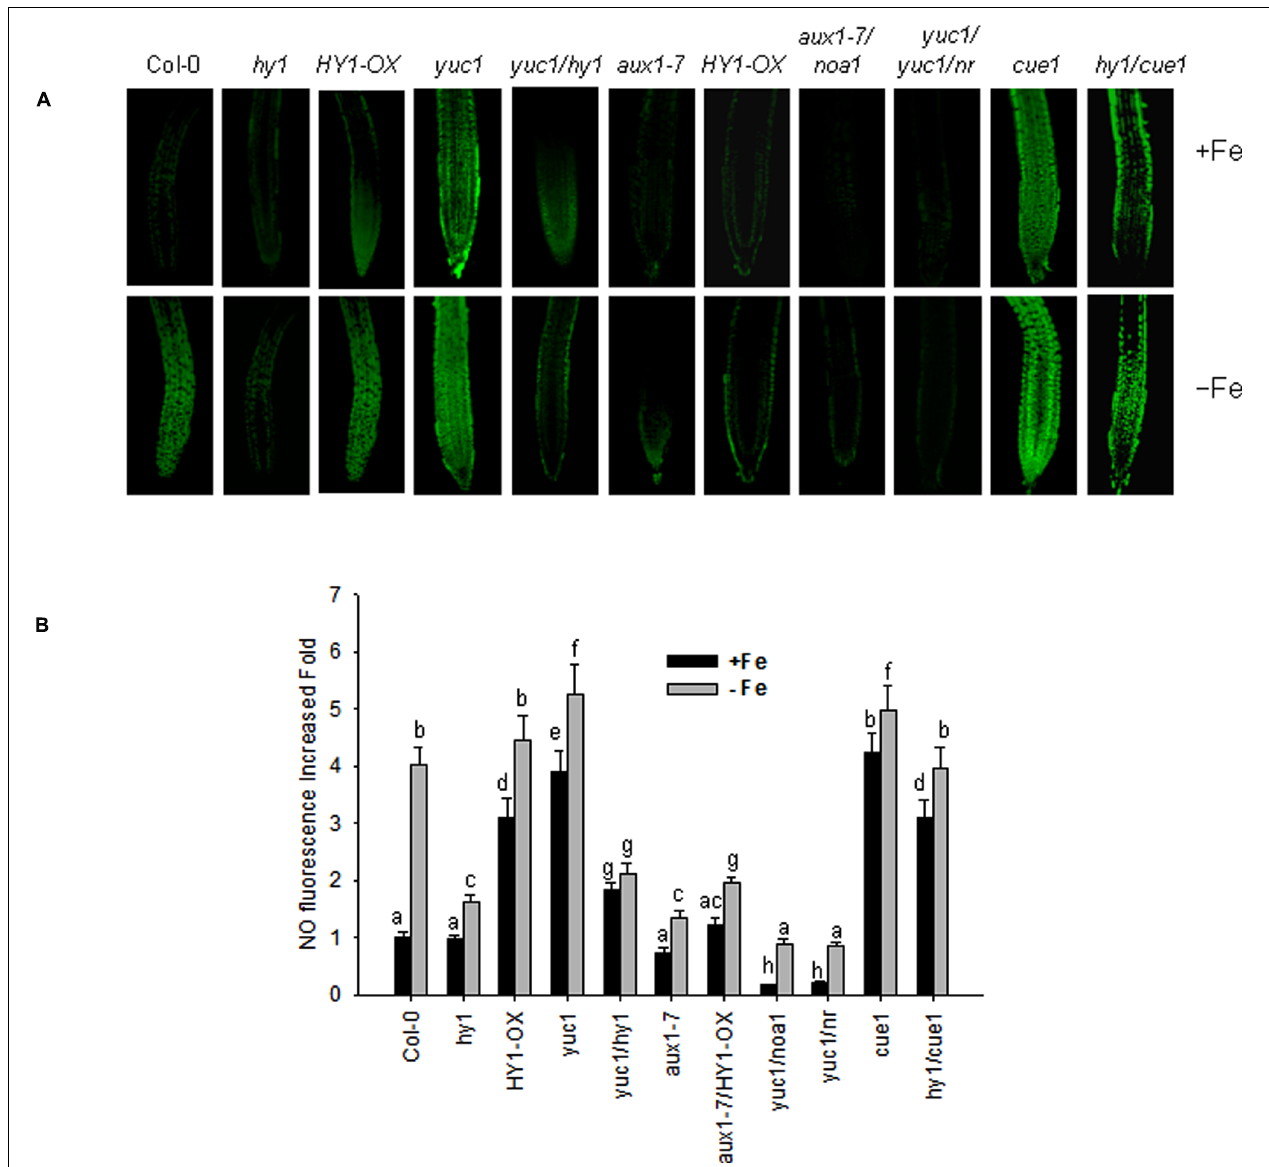
FIGURE 6 | Iron deficiency stress induced NO generation. Wild-type Col-0, hy1, HY1-OX, yuc1, yuc1/hy1, aux1-7, aux1-7/HY1-OX, yuc1/noa1, yuc1/nr, cue1, and hy1/cue1 lines were grown on + Fe media and then shifted or not to –Fe media, for 1 day. Green fluorescence indicates NO (A) . The corresponding relative fluorescence intensities (B) were recorded. Data are the means ± SD ( n = 15), and bars with different letters are significantly different at p < 0.05 (Tukey’s test). BAR = 0.1